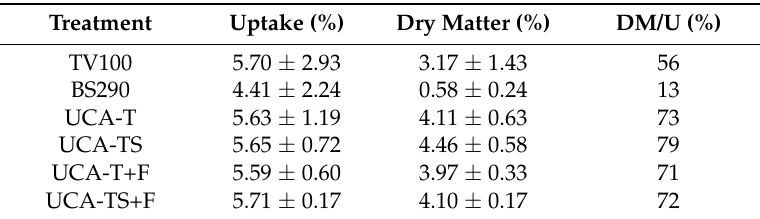
Table 1. Uptake, dry matter and percentage relationship between dry matter and uptake (DM/U) after the application of the treatments under laboratory